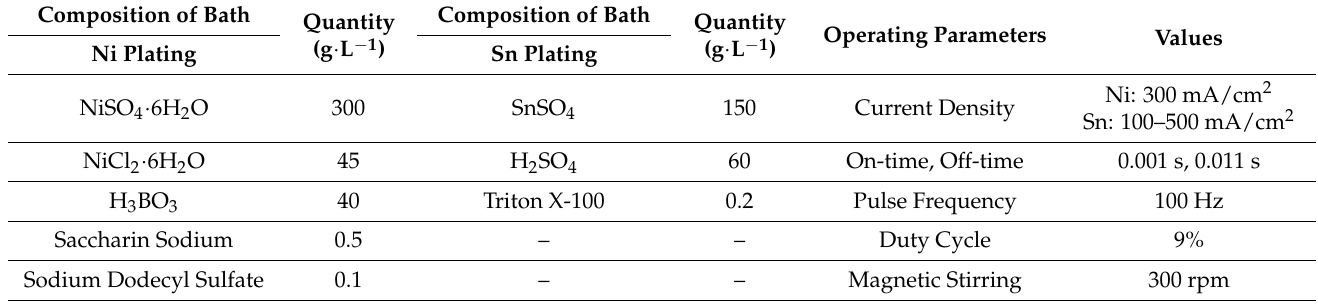
Table 1. Chemical bath compositions and operating parameters.